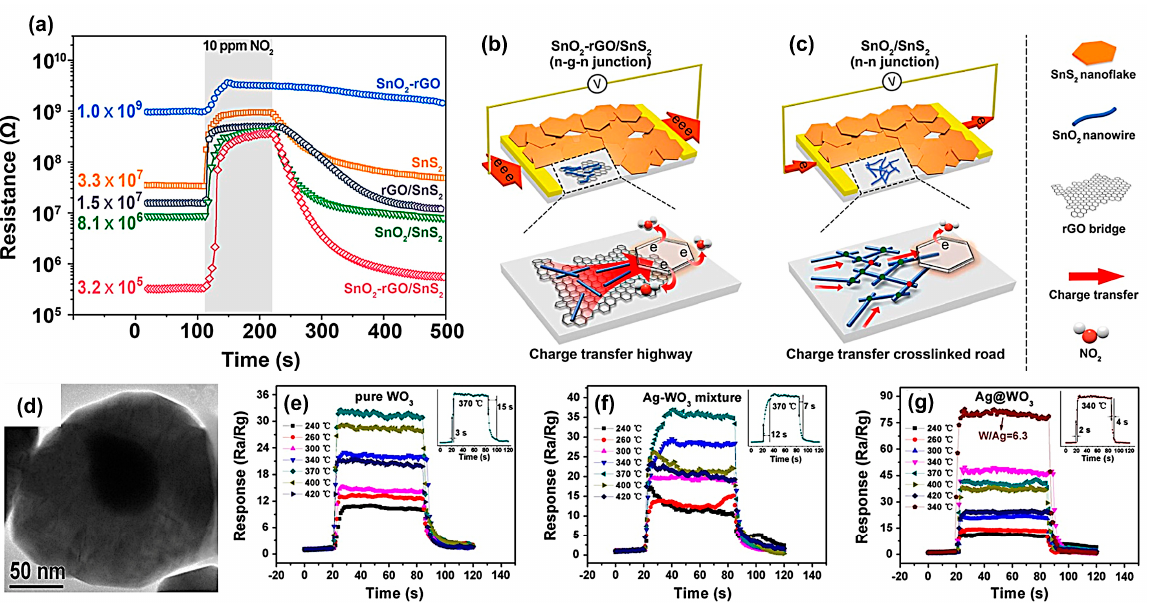
Figure 11. ( a ) Real-time resistance curves of SnO 2 -rGO, SnS 2 , SnO 2 /SnS 2 , and SnO 2 -rGO/SnS 2 sensors under 10 ppm NO 2 at 120 °C for comparison. Schematic illustration of charge transfer difference between ( b ) SnO 2 -rGO/SnS 2 sensor with novel n-g-n heterojunctions and ( c ) SnO 2 /SnS 2 sensor with traditional n-n junctions. Reprinted with permission from Ref. [116]. Copyright 2021, Elsevier. ( d ) TEM image of Ag@WO 3 core-shell nanostructures with the core and the shell clearly resolved. Tran- sient response at different temperatures for sensors using 100 ppm alcohol vapor exposure. The upper-right inset in each Figure shows corresponding response and recovery curves for the senor at its optimum working temperature. ( e ) Pure WO 3 , ( f ) Ag–WO 3 mixture, and ( g ) Ag@WO 3 . Reprinted with permission from Ref. [107]. Copyright 2015,